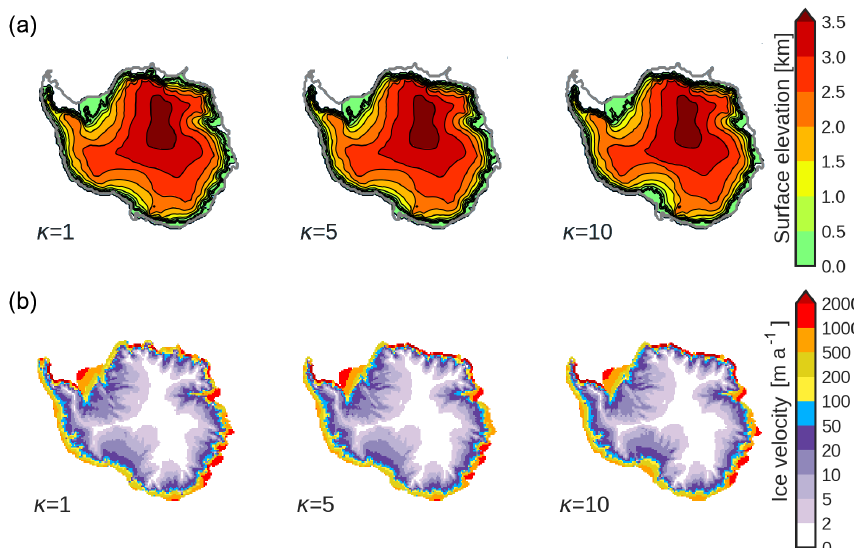
Figure 4. Snapshots of the AIS simulations at a cold phase (61ka) for three different oceanic sensitivities ( κ = 1, 5, and 10ma − 1 K − 1 ). (a) Surface elevation (in km). The thick black line indicates the grounding line position, and the thick grey line is the continental shelf break. (b) Ice velocities (in ma − 1